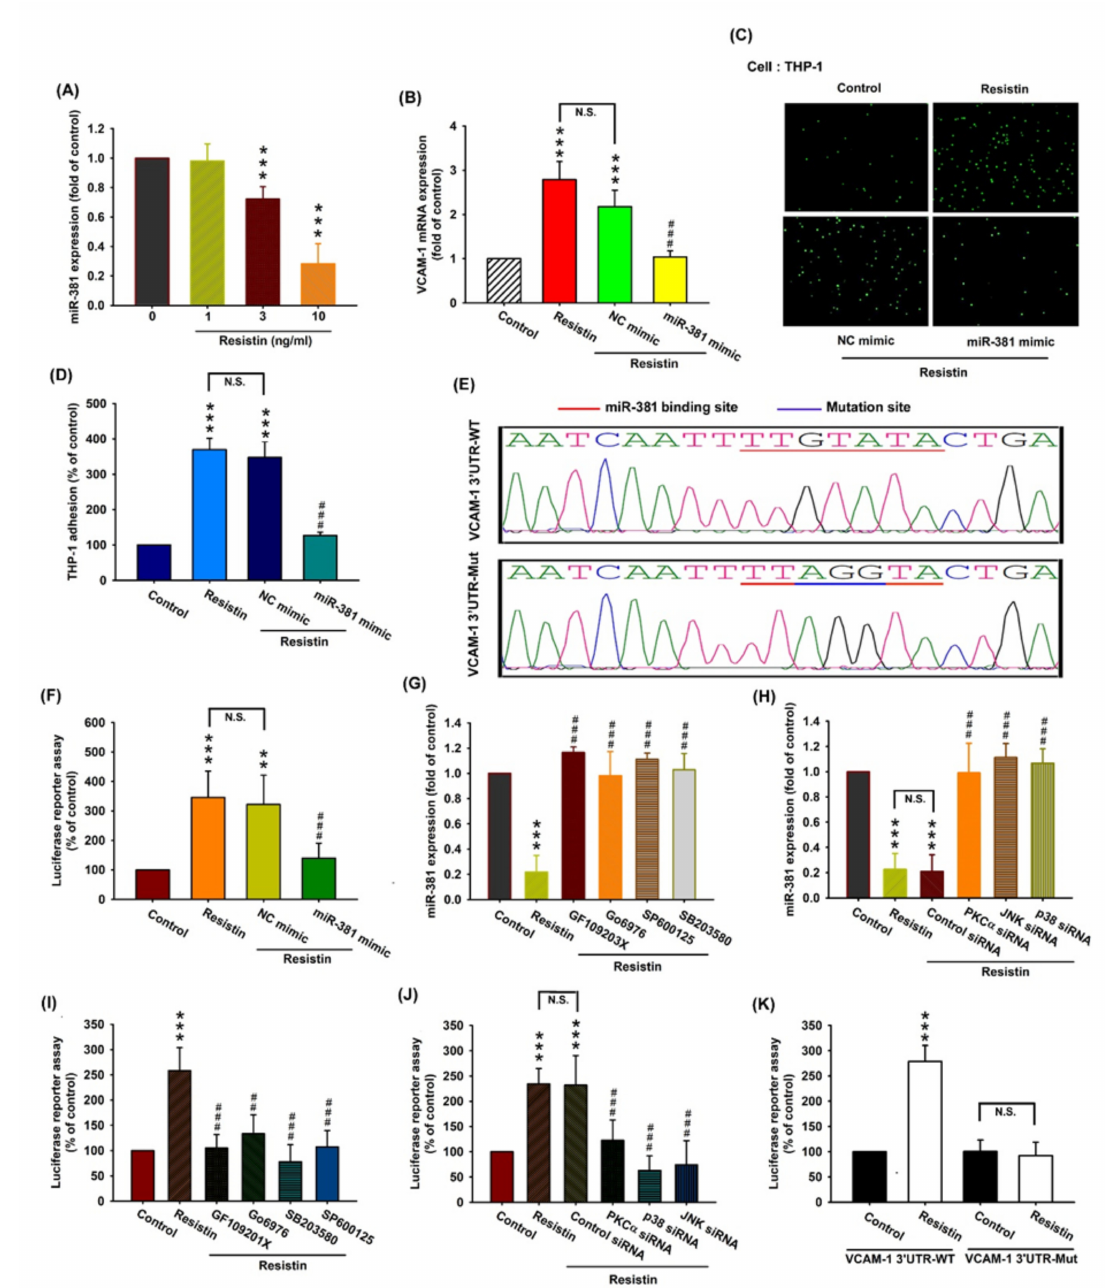
Figure 5. Resistin promotes VCAM-1 expression and monocyte adhesion by suppressing miR-381 expression. ( A ) OASFs were incubated with resistin (0, 1, 3, or 10 ng / mL), and the extent of miR-381 expression was quantified by the RT-qPCR assay. ( B – D ) OASFs were transfected with miR-381 mimic or control siRNA, then stimulated with resistin. The extent of VCAM-1 transcription was examined by the RT-qPCR assay (n = 4) ( B ). THP-1 cells were subsequently added to OASFs for 1 h. The adherence of THP-1 cells to cultured OASFs was photographed by fluorescence microscopy and quantified (n = 4) ( C , D ). ( E ) Schematic demonstration of wt-VCAM-1 3 (cid:48) -UTR and mut-VCAM-1 3 (cid:48) -UTR. MiR-381 bound with wt-VCAM-1 3 (cid:48) -UTR but not mut-VCAM-1 3 (cid:48) -UTR. ( F ) OASFs were transfected with the wt-VCAM-1-3’-UTR plasmid with or without miR-381 mimic, then stimulated with